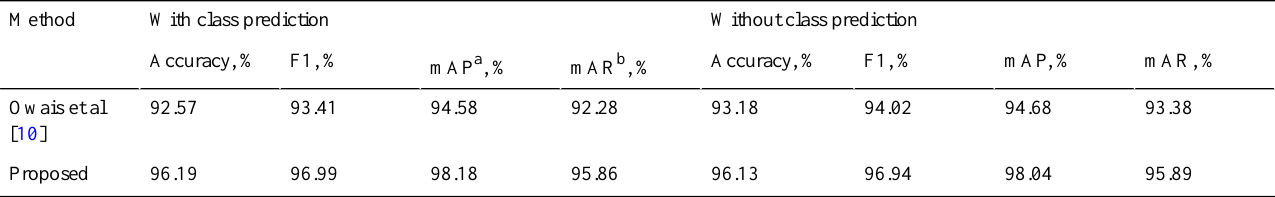
Table 5. Performance comparisons of our proposed and the second-best baseline method [10] using both retrieval methods.